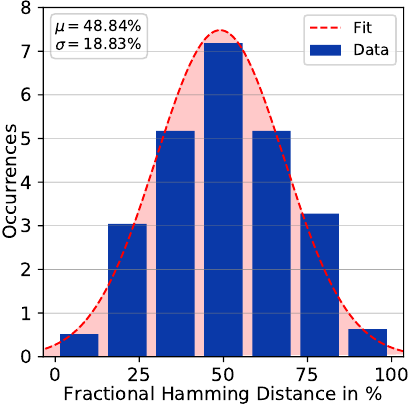
Figure 7. Uniqueness bar chart (test case P 11